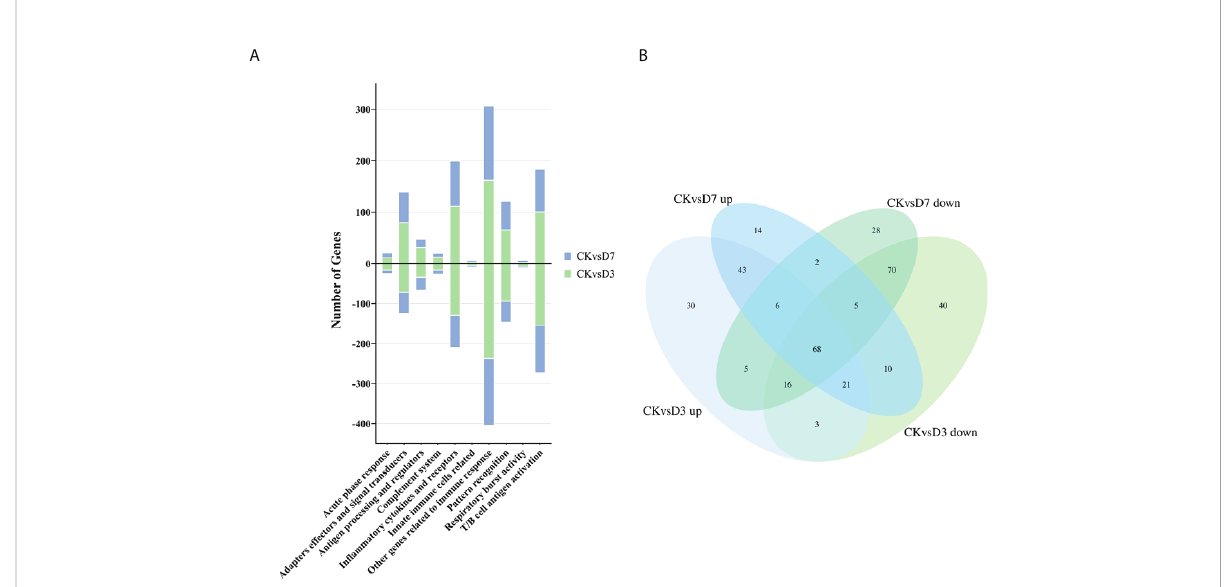
FIGURE 2 Analysis of the immune-related gene category. (A) Number of DEGs belonging to each of the 10 gene categories. (B) Venn diagram of the immune gene number of up- or downregulated DEGs in groups CK vs. D3 and CK vs.